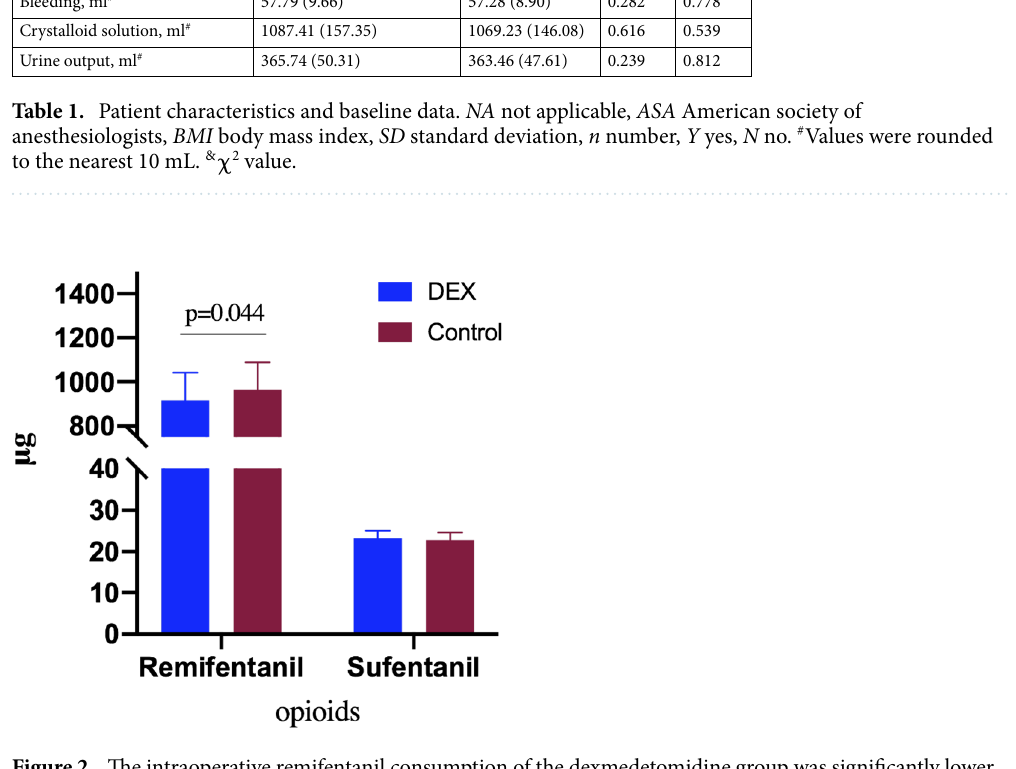
Figure 2. The intraoperative remifentanil consumption of the dexmedetomidine group was significantly lower than those of the control group. Meanwhile, intraoperative sufentanil consumption was similar. The dosages are presented as mean and standard deviation. DEX dexmedetomidine.